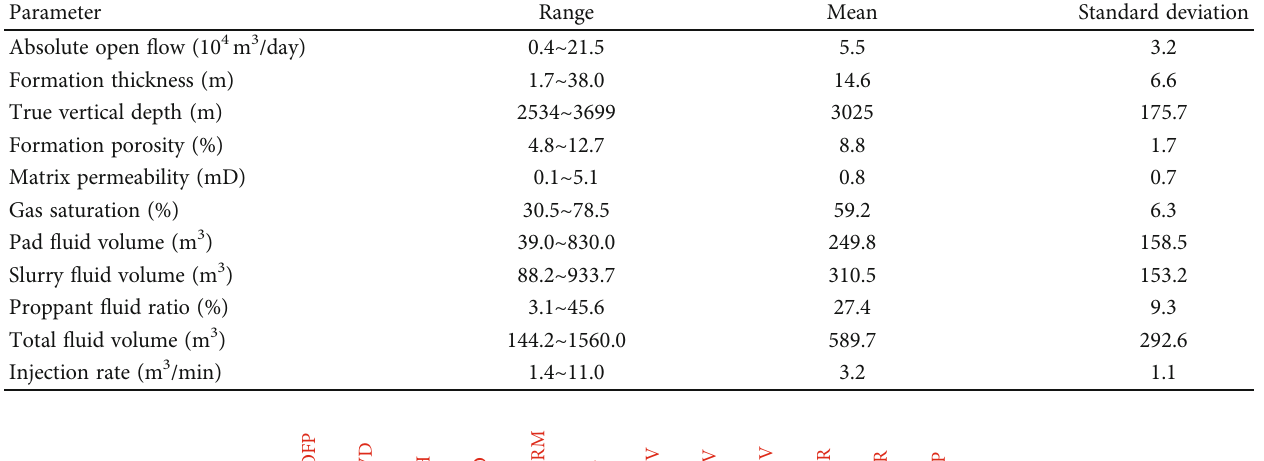
Table 2: Statistical properties of the variables.